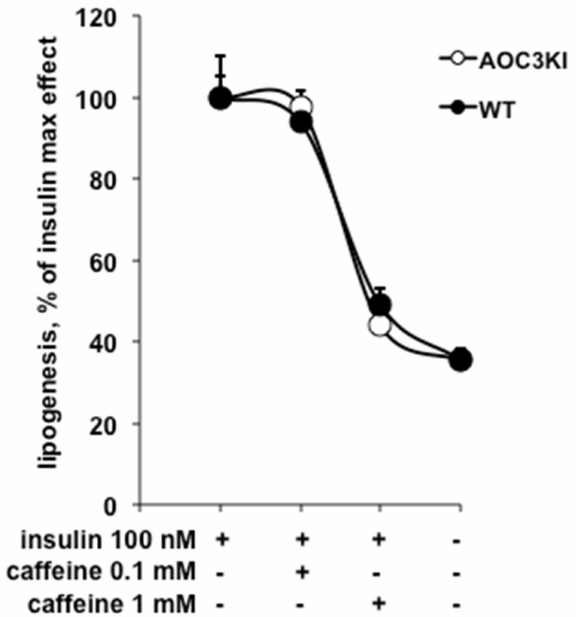
Figure 8. Caffeine impairs insulin-stimulated lipogenesis in mouse adipocytes irrespective of their SSAO/PrAO activity level. Insulin-stimulated lipogenesis was determined via the incorporation of [ 3 H]-glucose into lipids of adipocytes freshly isolated from wild-type (WT, black circles) or SSAO/PrAO-invalidated mice (AOC3KI, open circles) measured after 120 min incubation with 100 nM insulin. Lipogenesis is expressed on the Y-axis as percentage of glucose incorporation into adipocyte lipids in response to 100 nM insulin. The X-axis displays the following conditions: insulin, insulin with caffeine at two concentrations, basal. Each point is the mean ± SEM of 8–14 mice. No significant effect of SSAO/PrAO invalidation was detected on the antilipogenic effect of caffeine, which, at 1 mM, was significant at p < 0.001 in both